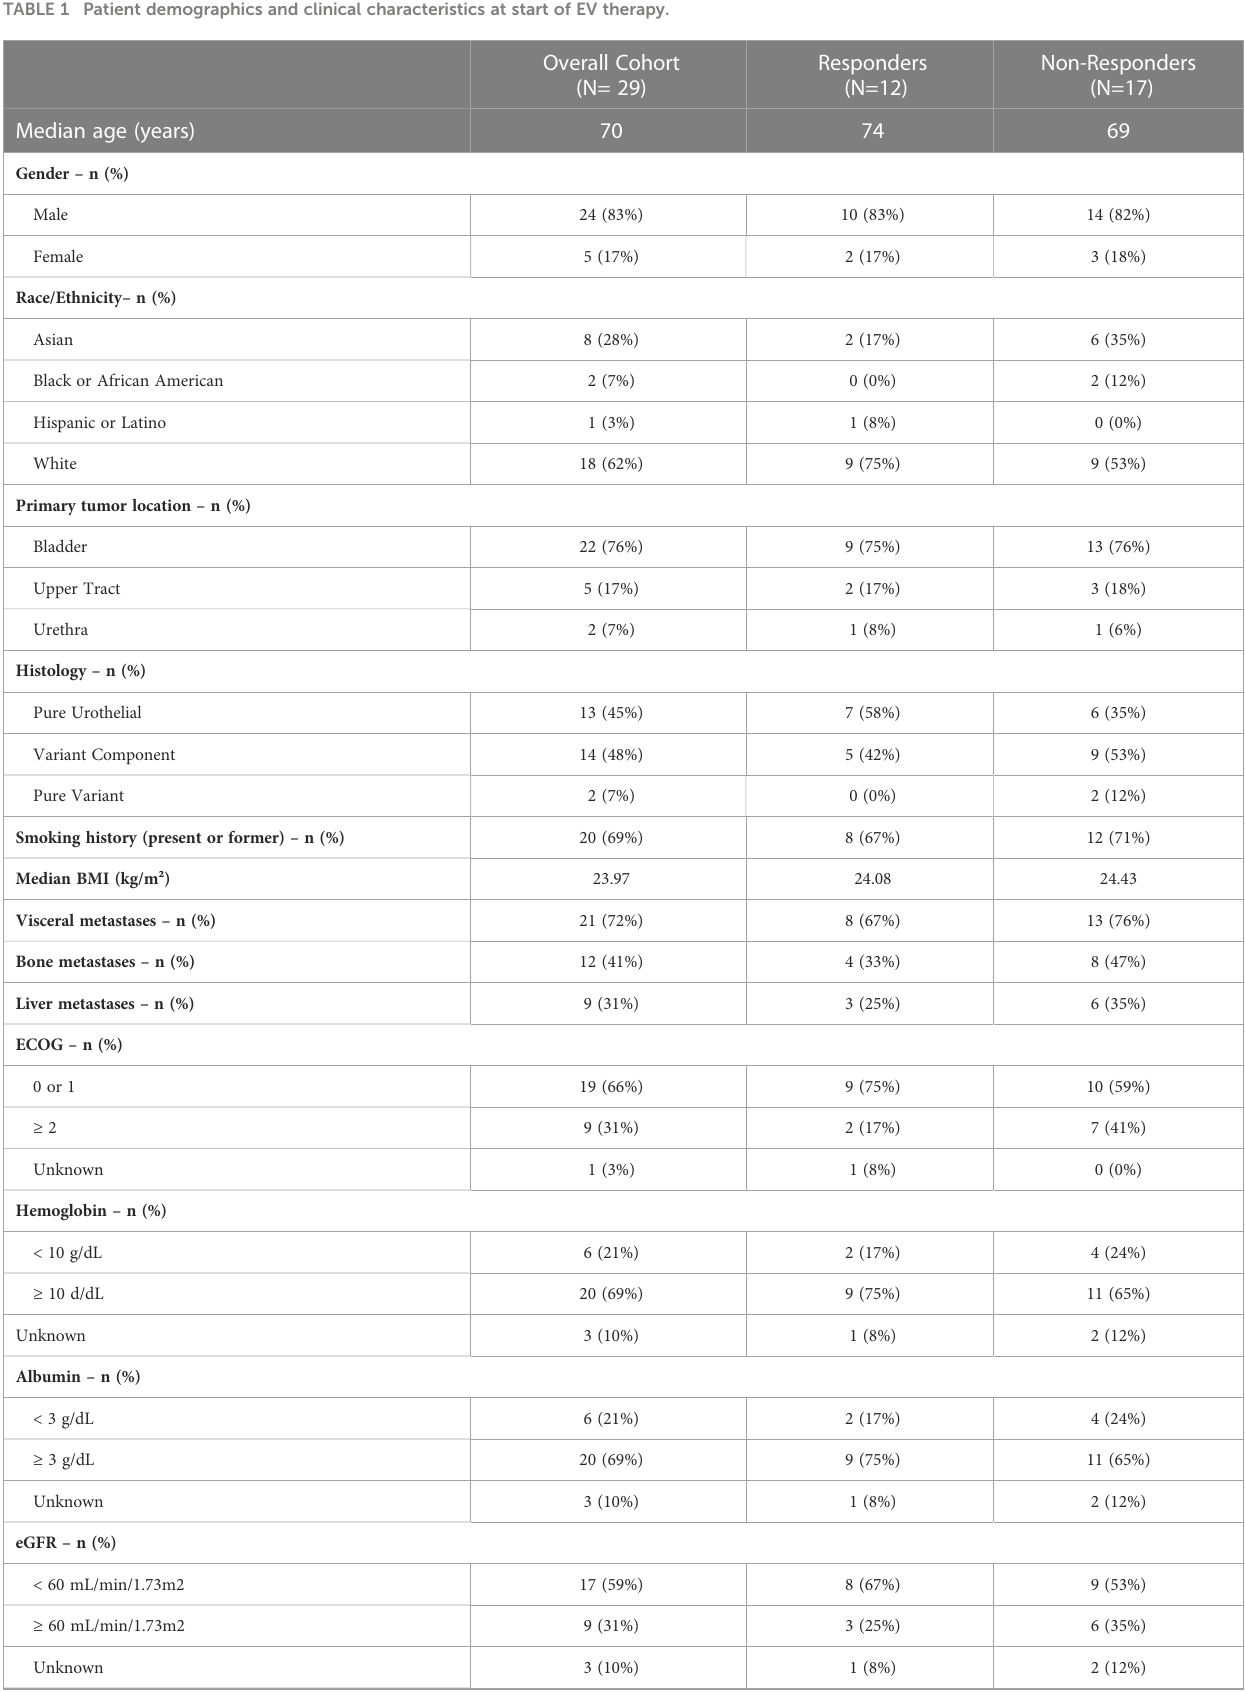
TABLE 1 Patient demographics and clinical characteristics at start of EV